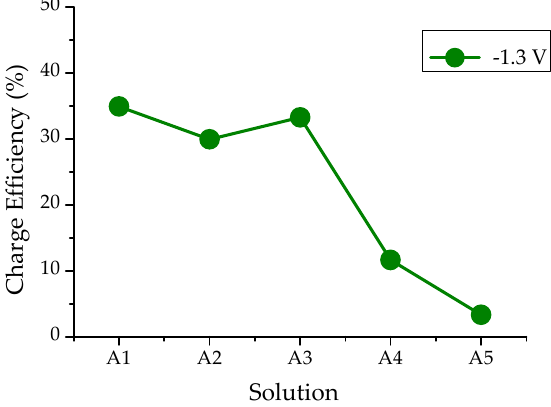
Figure 3. Charge efficiency of solutions A. Data obtained from cyclic voltammograms.